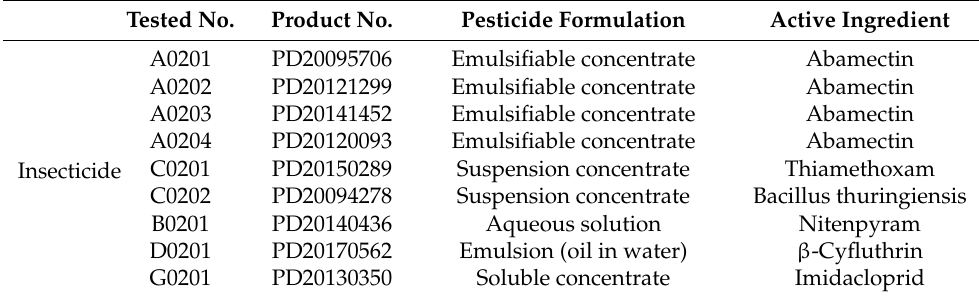
Table 1. General list of selected insecticides. Tested No. Product No. Pesticide Formulation Active